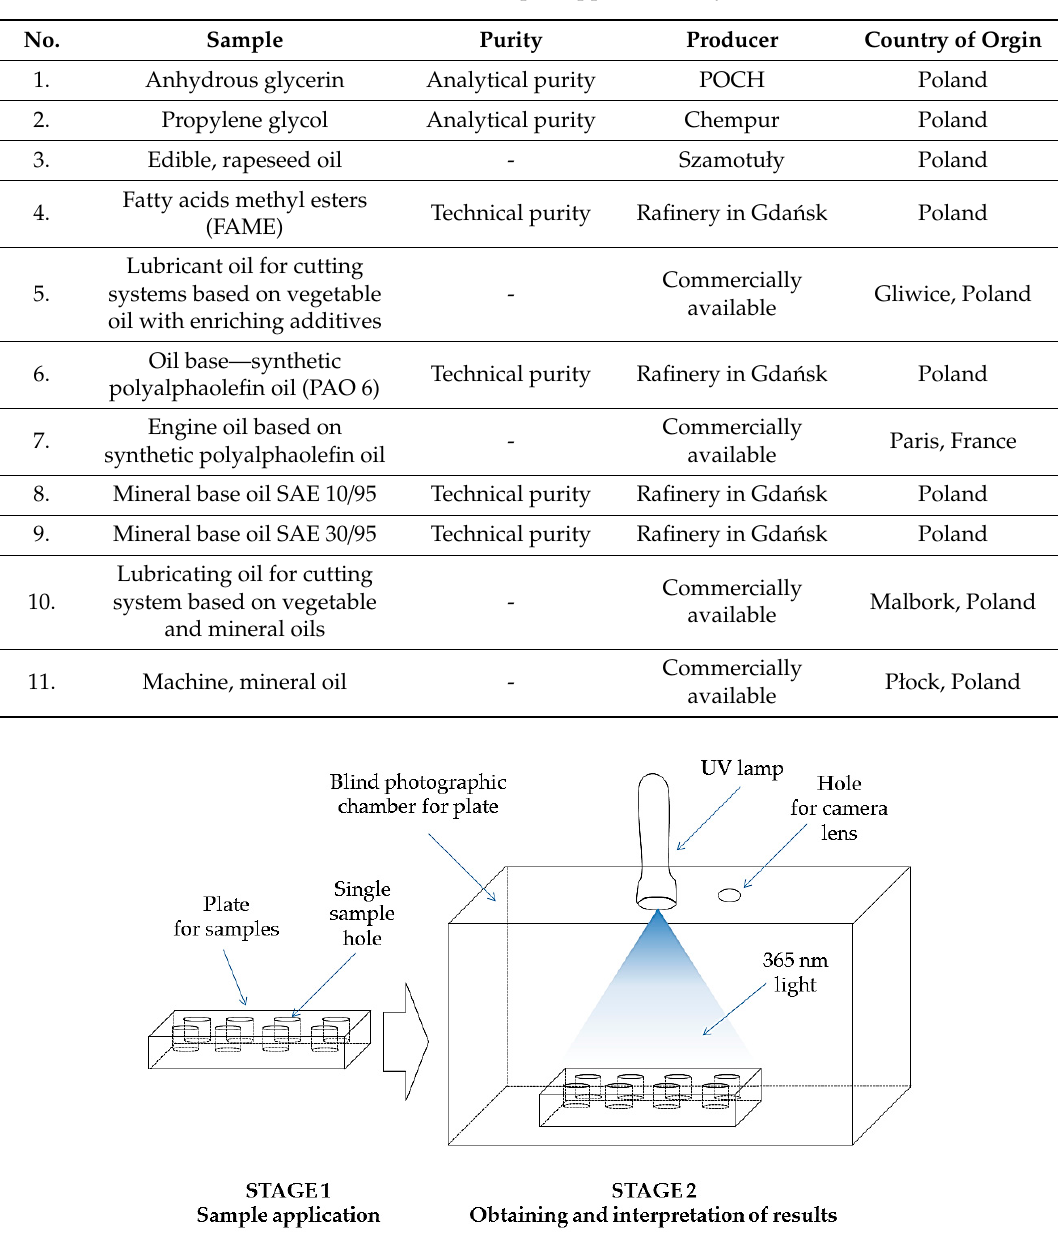
Table 1. List of oil samples applied in analyses.